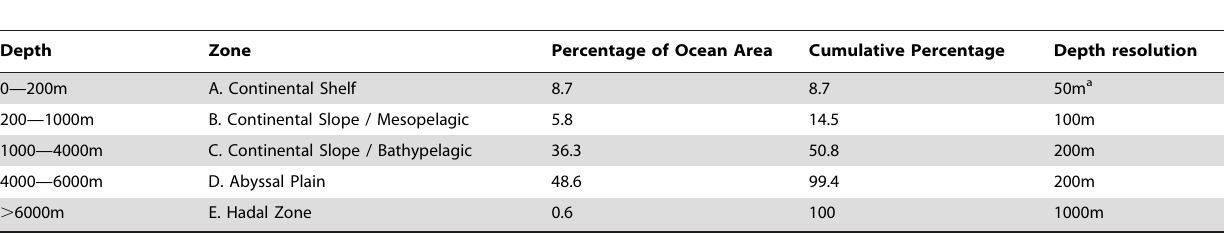
Table 1. Depth zones of the ocean, with the percentage of the global oceans occurring within each zone (estimated from data described in Ref.